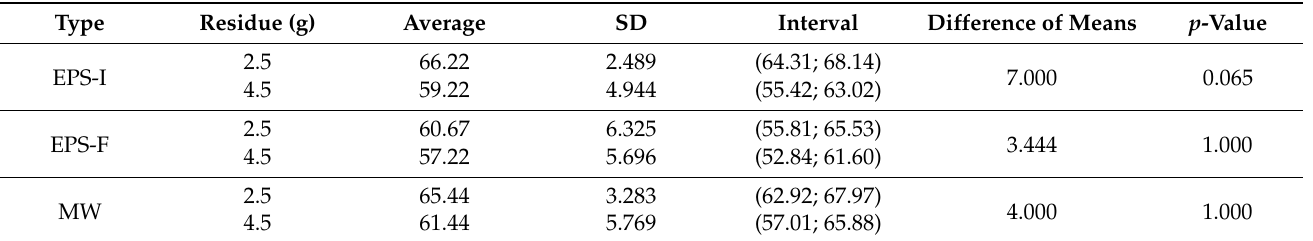
Table 14. Comparison for the Shore D surface hardness tests between mortars with the incorporation of thermal insulation materials.